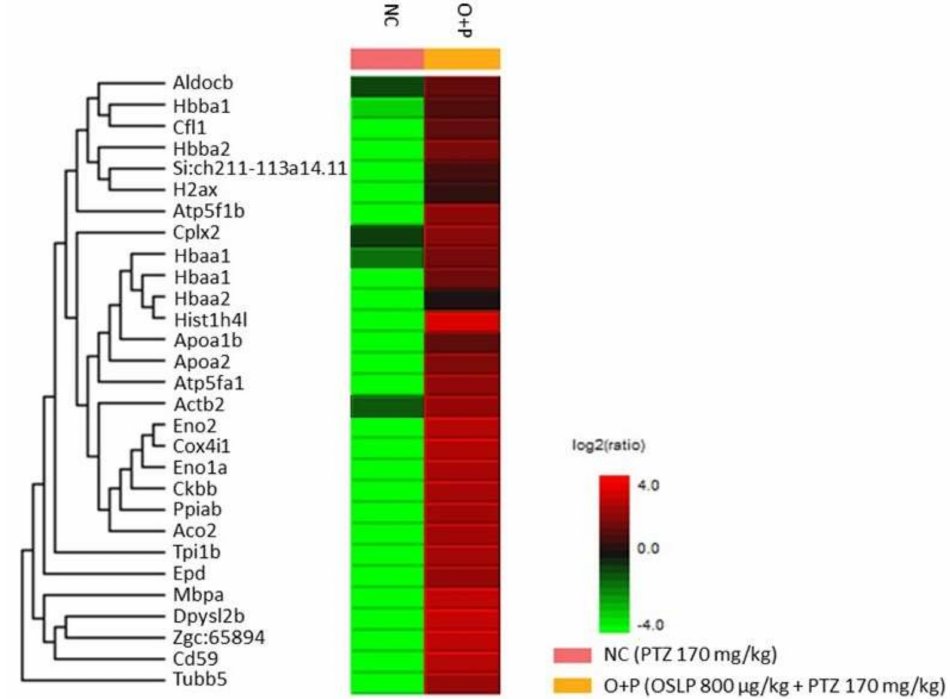
Figure 8. Heat map shows the di ff erentially expressed proteins identified from negative control (NC, PTZ 170 mg / kg only) and O + P (OSLP 800 µ g / kg + PTZ 170 mg / kg) zebrafish brains, n = 4, significance ≥ 20, FDR ≤ 1%, fold change ≥ 1, unique peptide ≥ 1. Protein names are listed on the left while experimental groups are indicated on top. The color key on the bottom right indicates the log2 (ratio) expression levels (green = low and red =